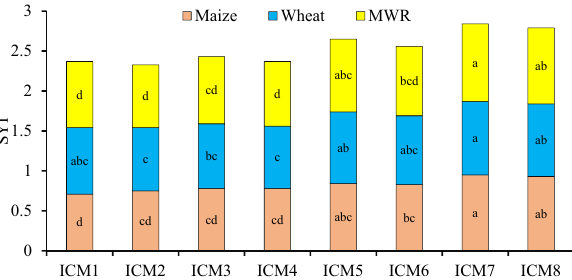
Figure 5. Effect of ICM modules on sustainable yield index (S YI ) of the maize, wheat and maize-wheat rotation. Means followed by a similar lowercase letter within a bar are not significantly different at p < 0.05 using Tukey’s HSD test.